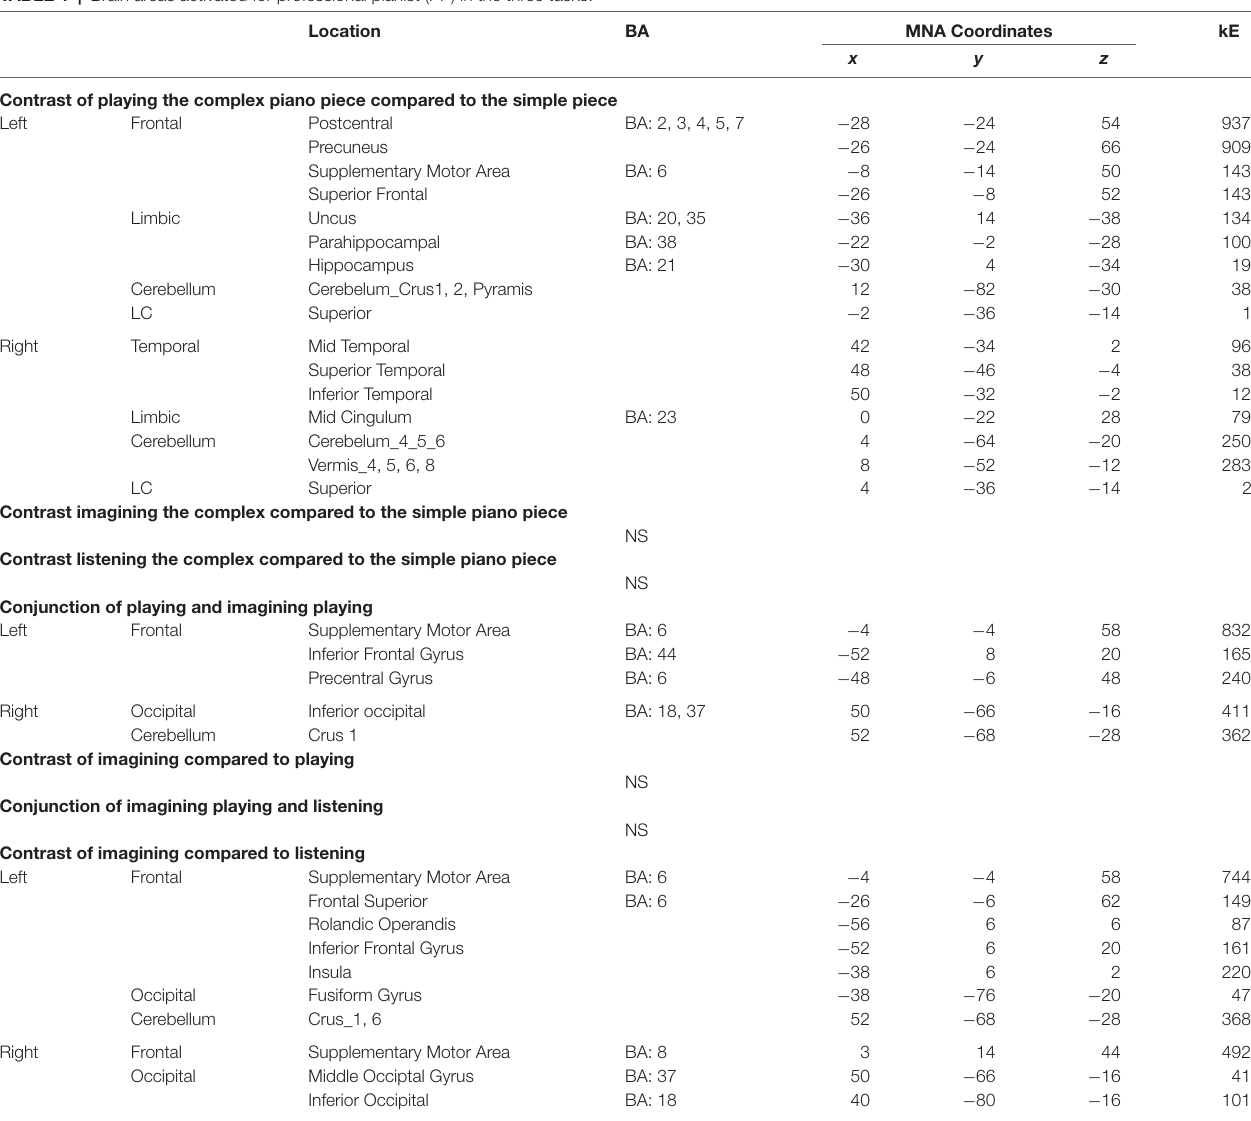
TABLE 1 | Brain areas activated for professional pianist (PP) in the three tasks. Location BA MNA